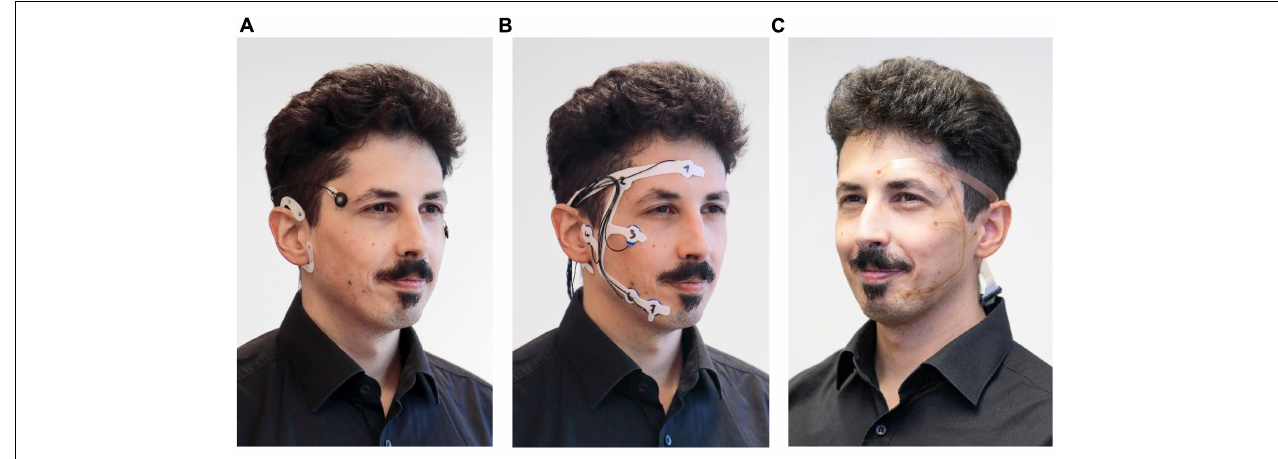
FIGURE 1 | Development steps of the self-applicable, pre-gelled trEEGrid . (A) stage 1: cEEGrid + EOG, da Silva Souto et al. (2021). (B) stage 2: foam trEEGrid , current study. (C) stage 3: trEEGrid prototype on a flexible PCB, future development. ©Fraunhofer IDMT/Anika